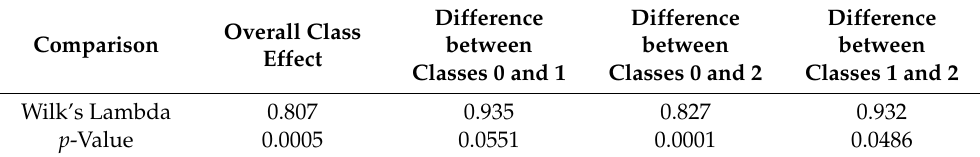
Table 7. MANOVA Test: Wilk’s Lambda for level of investment. Comparison